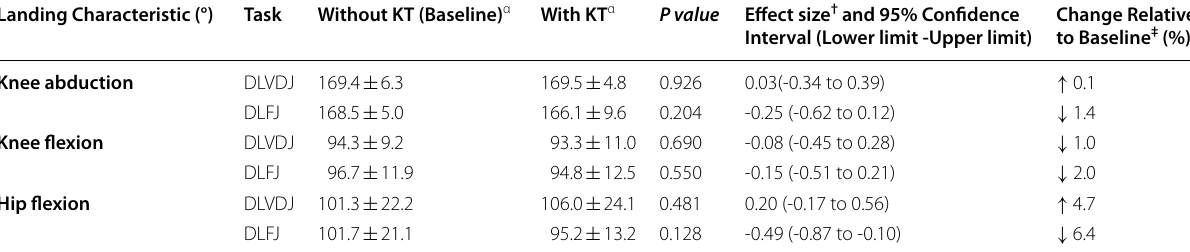
Table 3 Peak angles of knee abduction, knee flexion and hip flexion during DLVDJ, DLFJ tasks